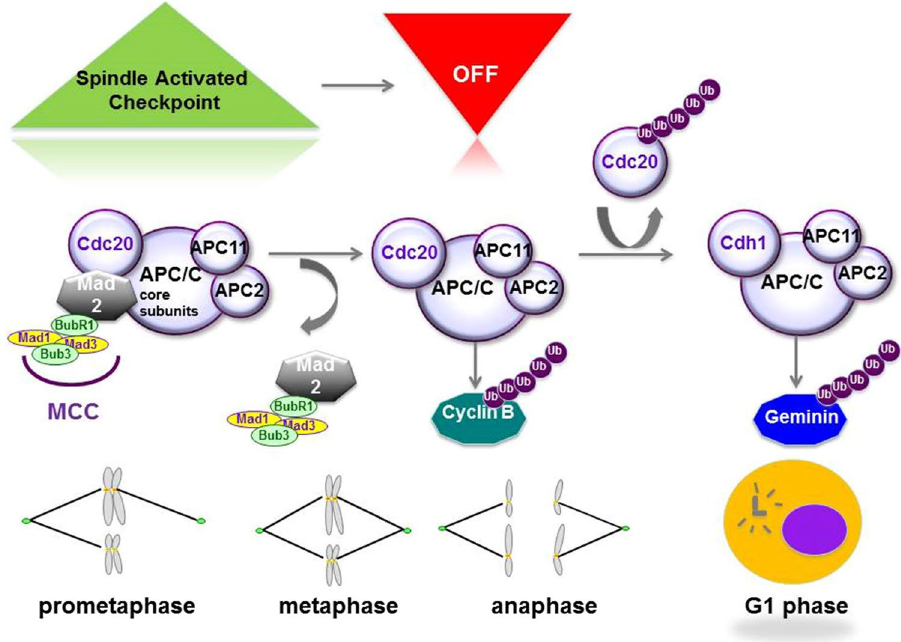
Figure 1. Regulation and function of APC/C. The activator of APC/C, CDC20 (cell division cycle 20) is inhibited by MCC (Mad2, BubR1, Mad1, Mad3) sequestration until all of the spindles have attached to kinetochores at metaphase; this system is referred to as the SAC (spindle activated checkpoint). Once all of the chromosomes are bi-orientated on a metaphase plate, the SAC is extinguished. Release from SAC activates APC/CCDC20. APC2/APC11 catalytic E3 sub-complex activity promotes proteolysis by poly-ubiquitination of APC/C targets, such as cyclin B, leading to anaphase onset. APC/C then switches its activator from